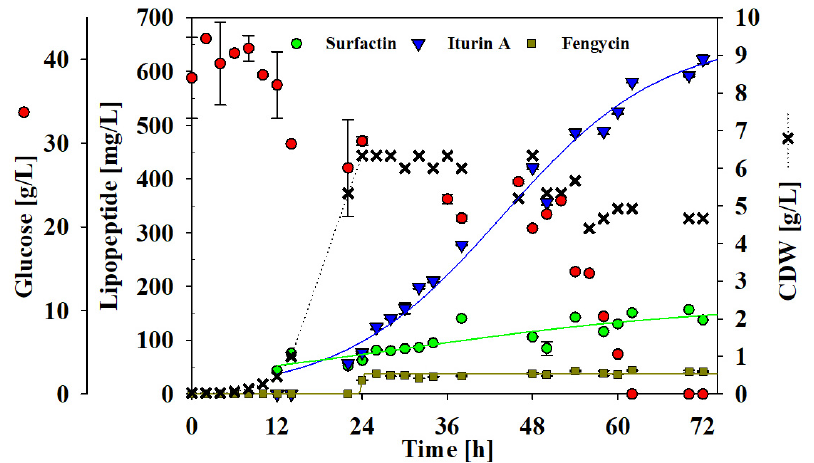
Figure 5. Time course of the cell dry mass (CDW) of the glucose and lipopeptide concentrations during a batch bioreactor fermentation with strain UTB96, glucose (red dots), CDW (black crosses), and the lipopeptide concentration of surfactin (green dots), iturin A (blue inverted triangles) and fengycin (brown squares).